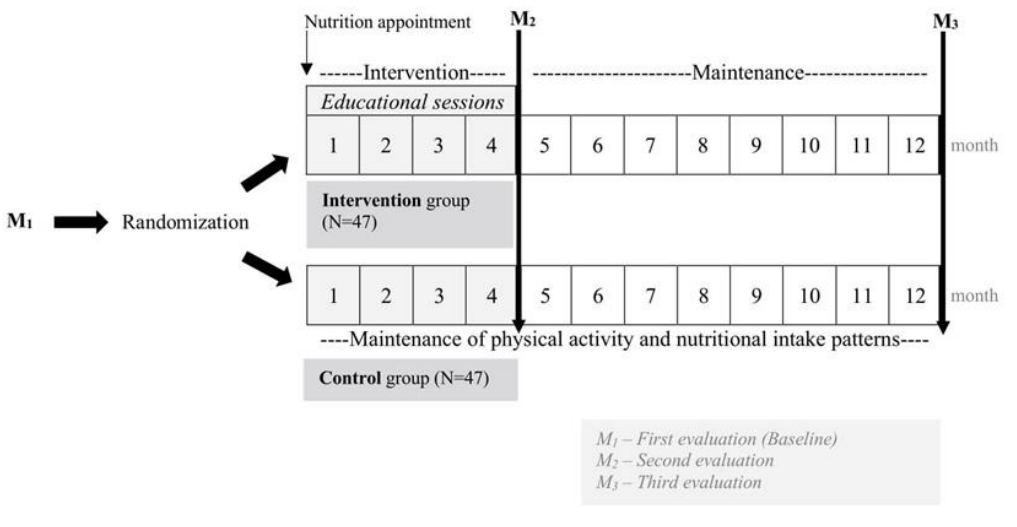
Figure 1. Schematic description of the study phases.